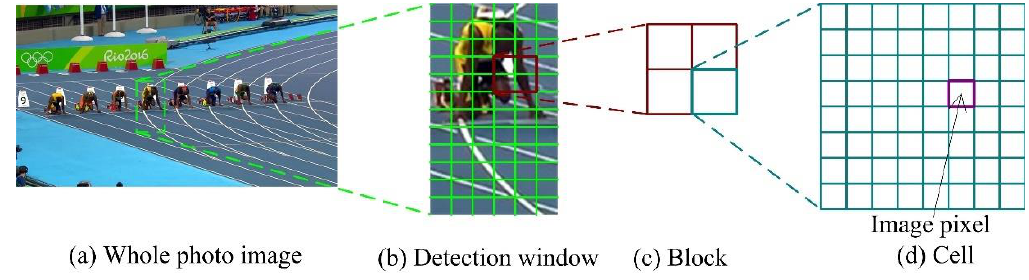
Figure 5. Whole image, detection window, block, cell, and image pixel.